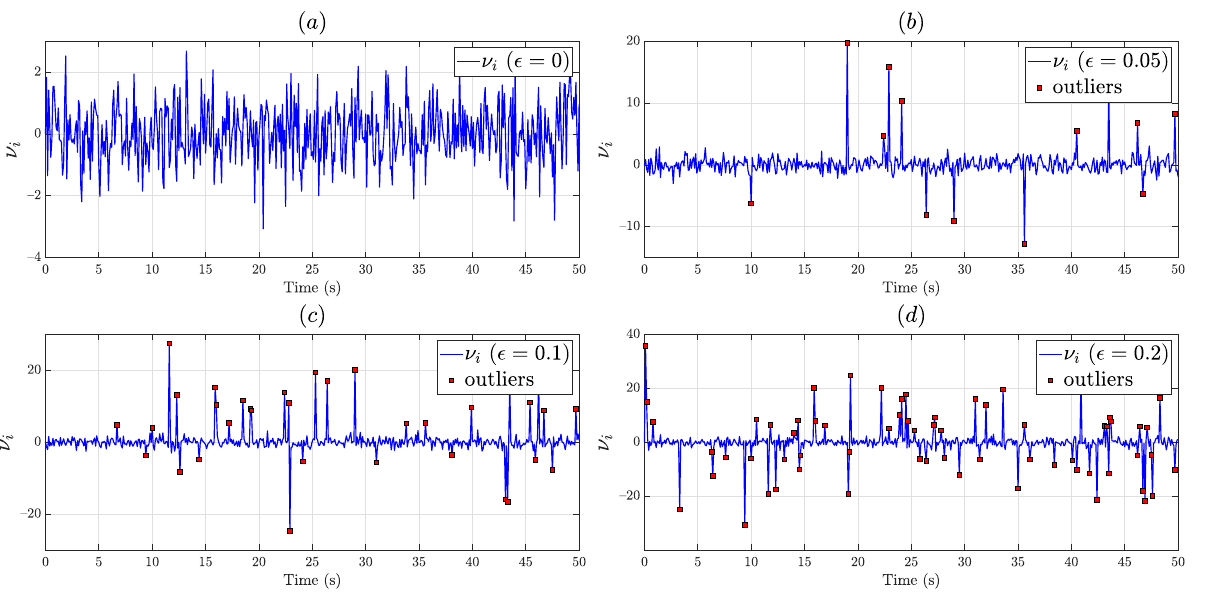
Figure 5. Gaussian, Laplace, (cid:101) -contaminated Gaussian, and Cauchy densities. The latter three densities have noticeably heavier tails.